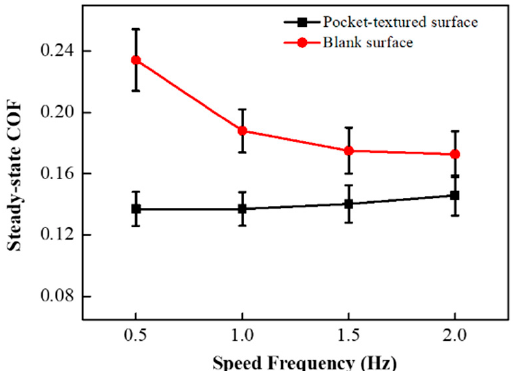
Figure 6. Steady-state COF of the pocket-textured surface and blank surface under different sliding frequencies while the load is kept at 2 N.